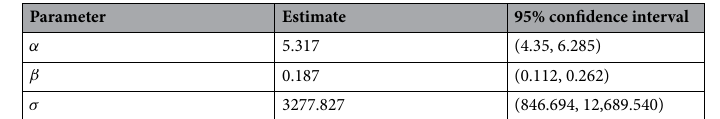
Table 1. Maximum likelihood estimates for the models for IgG S1-RBD, after excluding days post-onset of symptom variable.